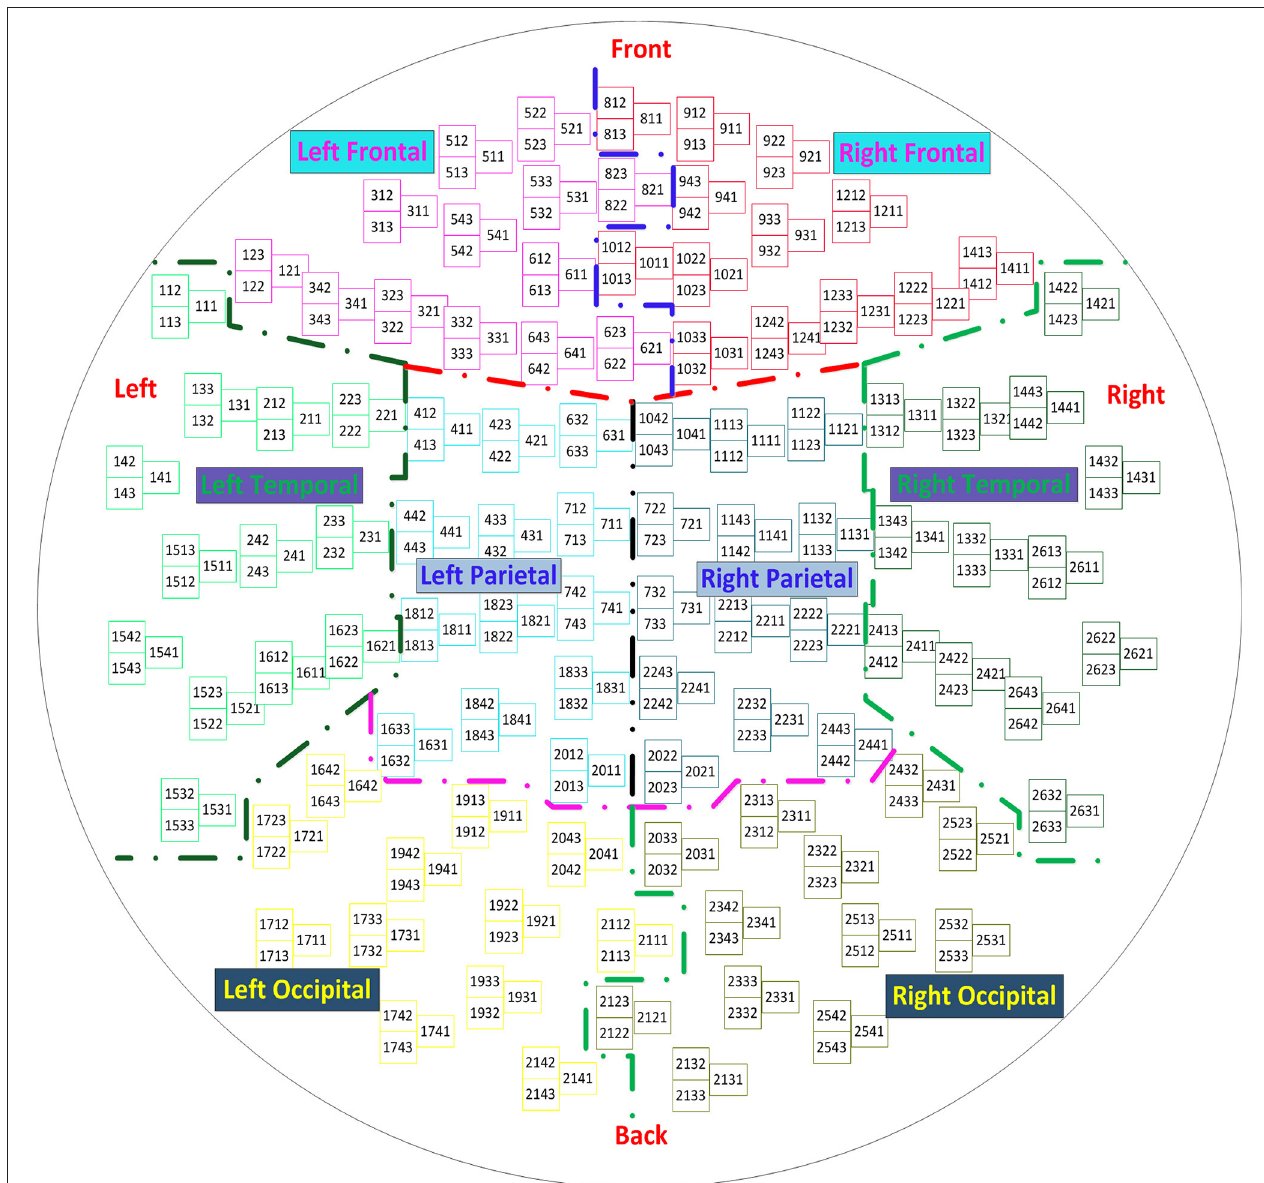
FIGURE 1 | Layout of the sensor elements. The helmet-shaped sensor array is flattened into a plane, and the 306 sensor channels are divided into eight brain regions: frontal lobes (left and right), temporal lobes (left and right), parietal lobes (left and right), and occipital lobes (left and right).